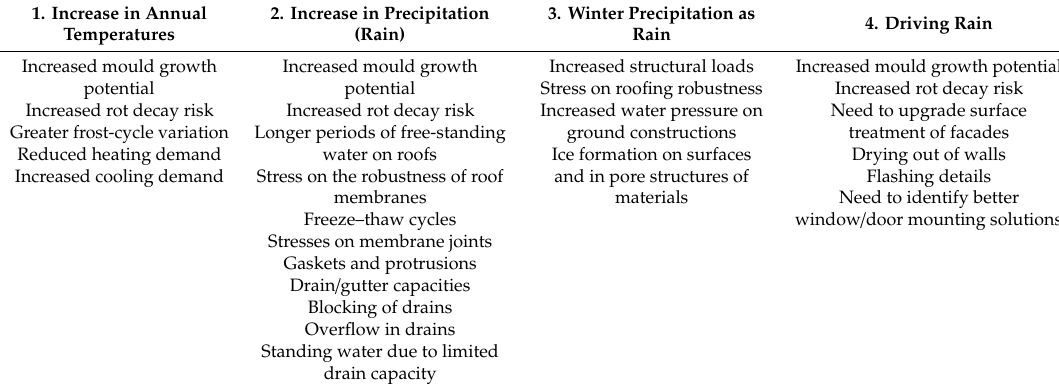
Table 3. Climate change factors and associated technical challenges. This table has previously been presented in Grynning et al.